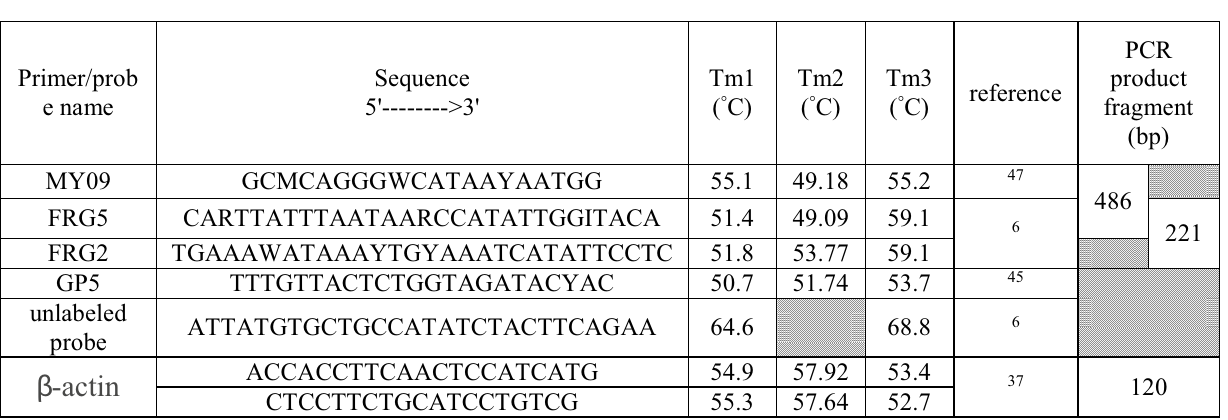
Table 2. Degenerate primers and unlabeled probes applied for genotyping human papillomaviruses by a high- resolution melting technique. Tm1 Melting temperature settings in OligoAnalyser 3.1, qPCR defaultsl; Tm2 Melting temperature settings in NCBI (Primer Blast); Tm3 Melting temperature settings by synthesized primer company. *Unlabeled probes are inexpensive, provide the sequence specificity of probes, and allow simultaneous identification of multiple alleles by melting